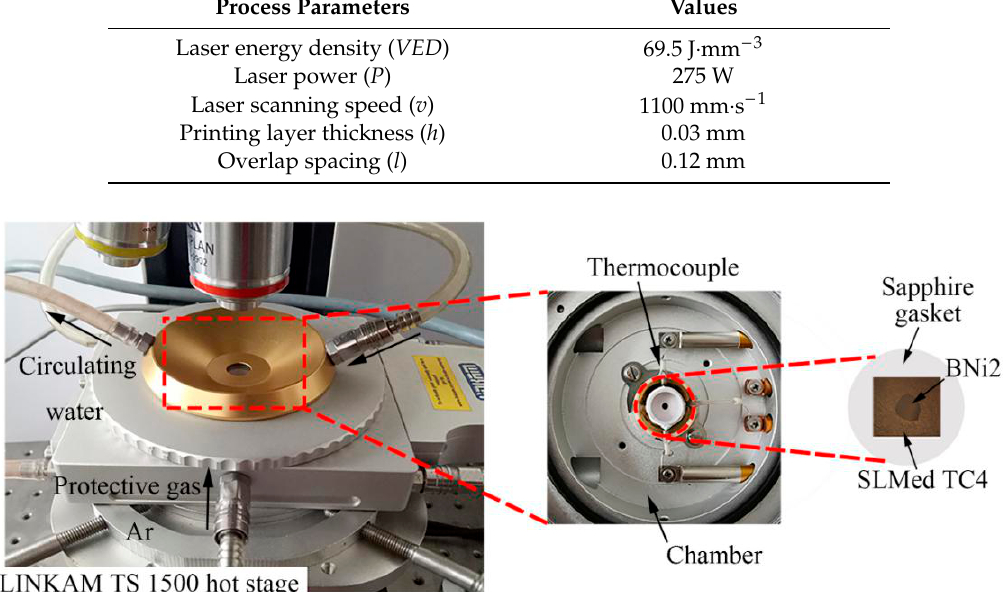
Figure 1. The experimental equipment.